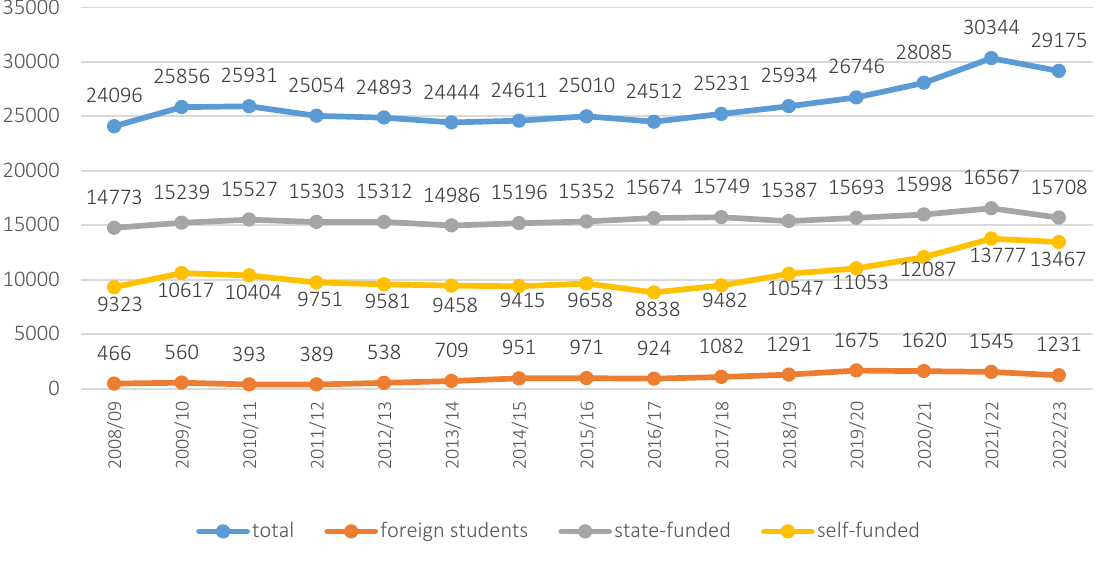
Figure 1. Dynamics of changes in the number of undergraduate and graduate students from 2008 to